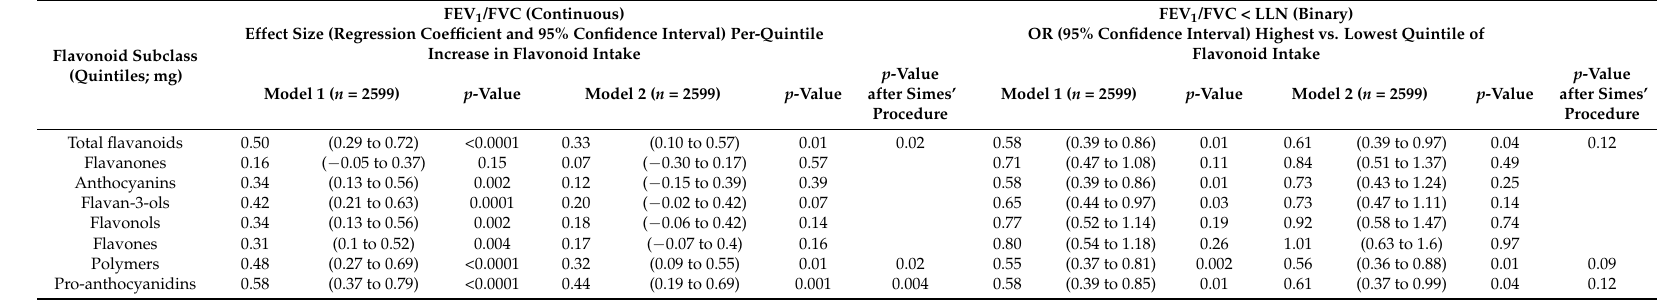
Table 5. Association of post-bronchodilator ratio FEV 1 /FVC and FEV 1 /FVC < LLN with dietary intake of